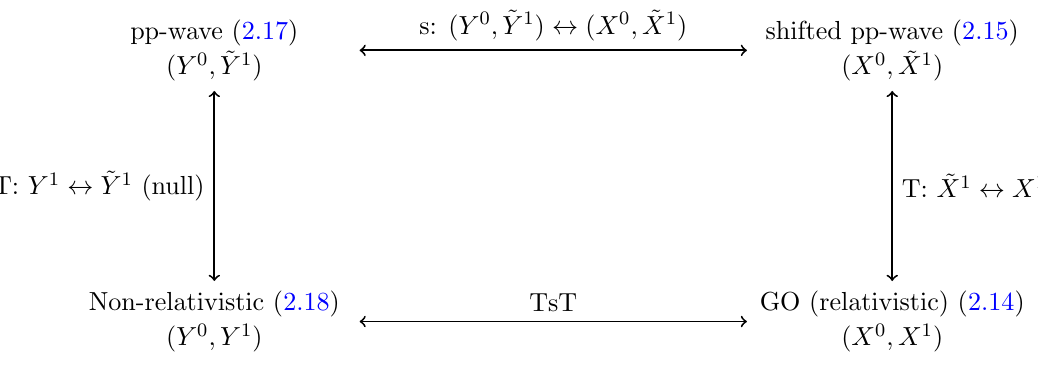
Figure 1 . Duality between our example non-relativistic and relativistic